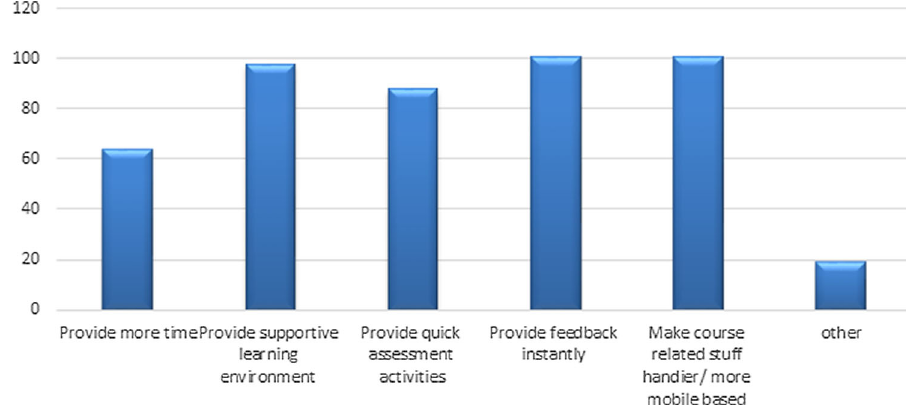
Figure 1. Students suggestions for the instructor to do differently to help them to learn more.